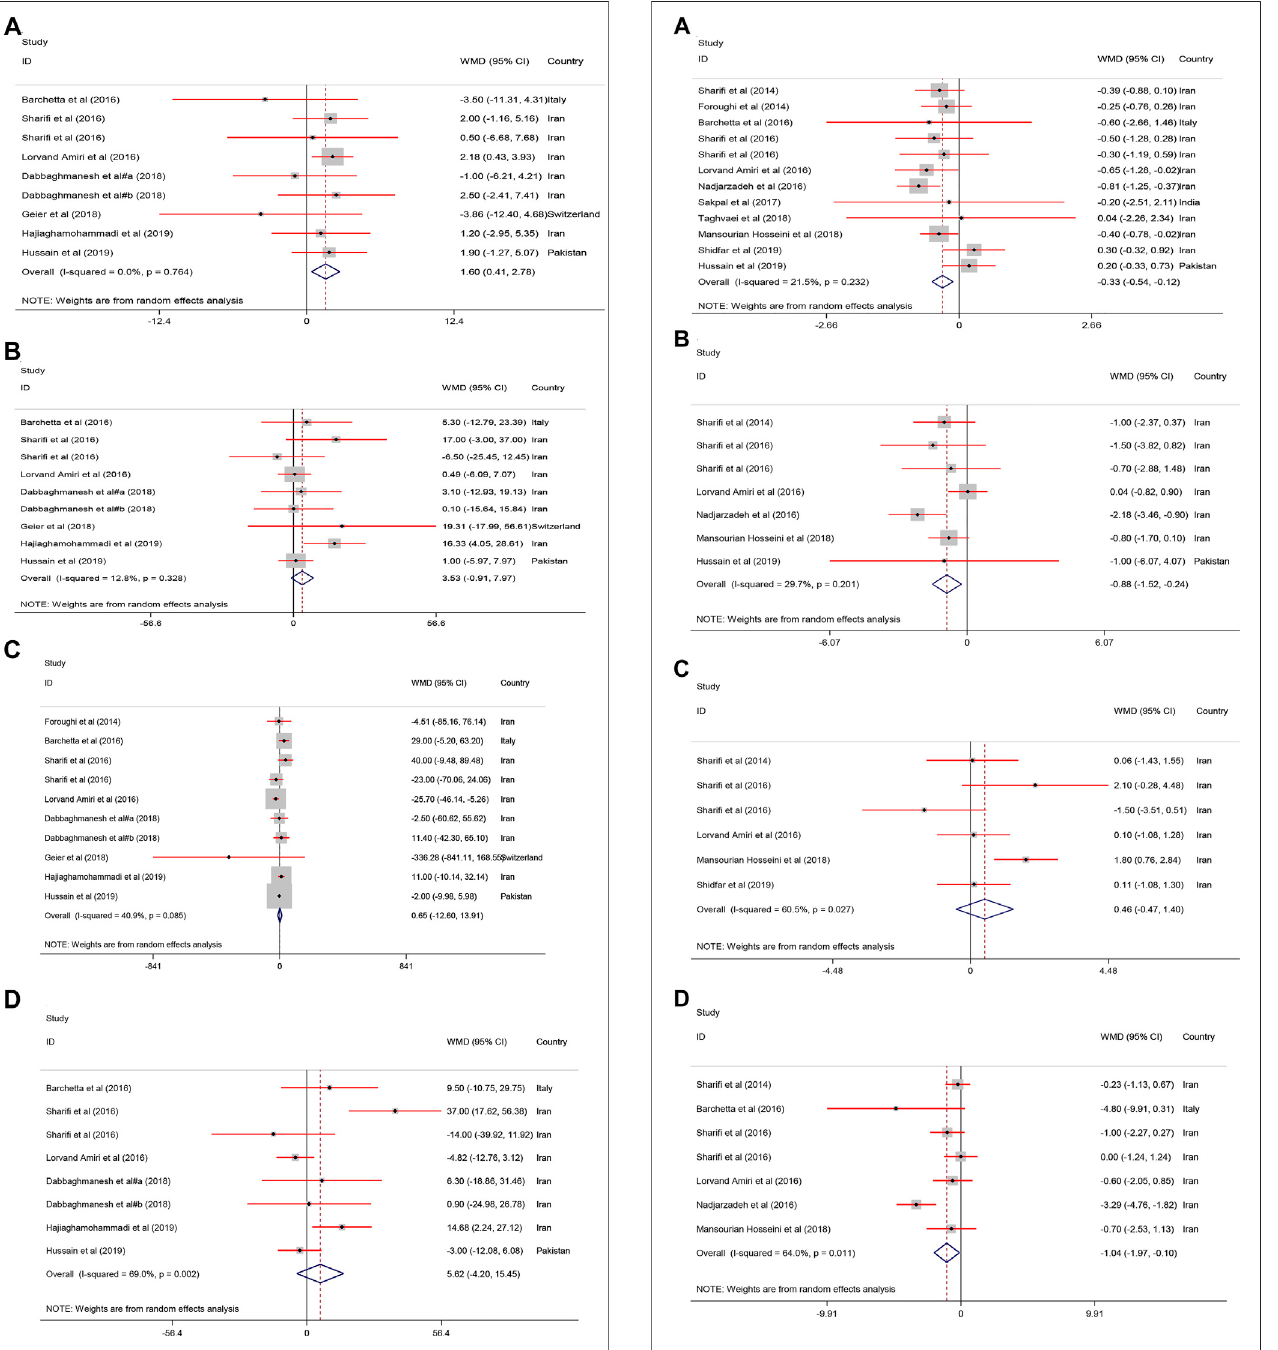
FIGURE2| Thelipidpro fi lestandardizedmeandifferencesestimatesfor (A) HDL − C, (B) LDL − C, (C) TG and (D) TC between intervention group (receiving vitamin D supplementation) and placebo groups.